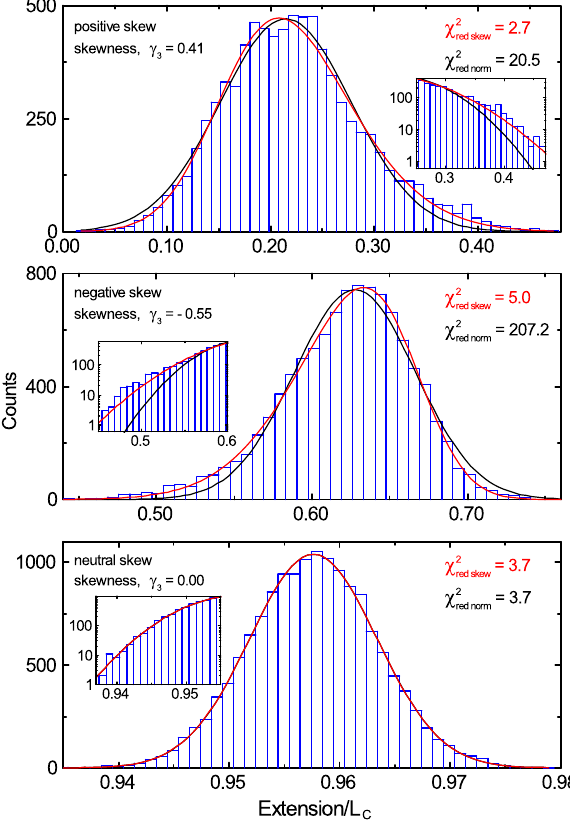
Figure 5. Representative experimental data for a 12 kb DNA molecule exhibiting non-normal distributions in axial position. Top) Positive skew at low force ( 0 : 025 pN ) corresponds to a mismeasurement of 0 : 063 + 0 : 003 in extension/ L C . Middle) Negative skew at medium force ( 0 : 141 pN ) corresponds to a mismeasurement of 0 : 042 + 0 : 008 . Bottom) No skew at high force ( 3 : 313 pN ). The inset log- linear zooms display the same data and more clearly show the large discrepancy of the data from a normal distribution, indicating that the skew normal distribution is a much better fit.